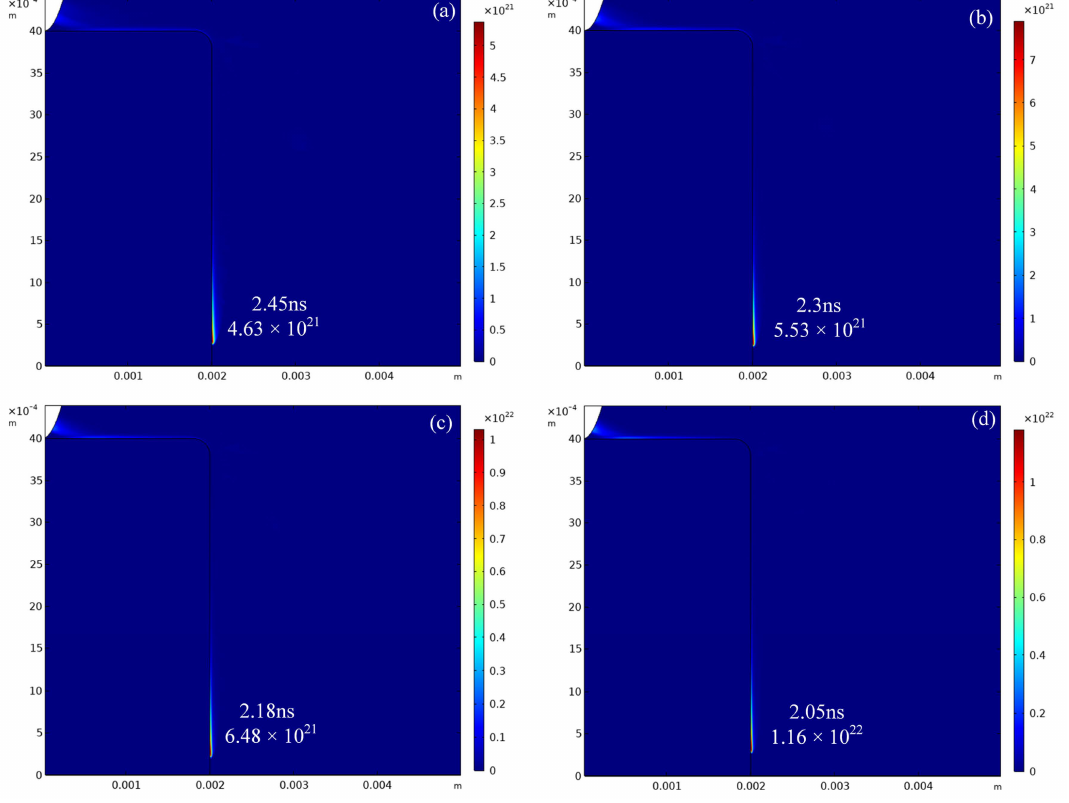
Figure 11. Electron concentrations of different dielectric constants: ( a ) ε r = 2; ( b ) ε r = 3; ( c ) ε r = 4; ( d ) ε r =